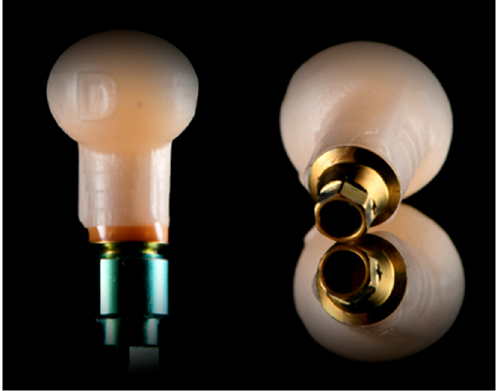
Figure 2. Titanium-base abutments after the bonding procedure.